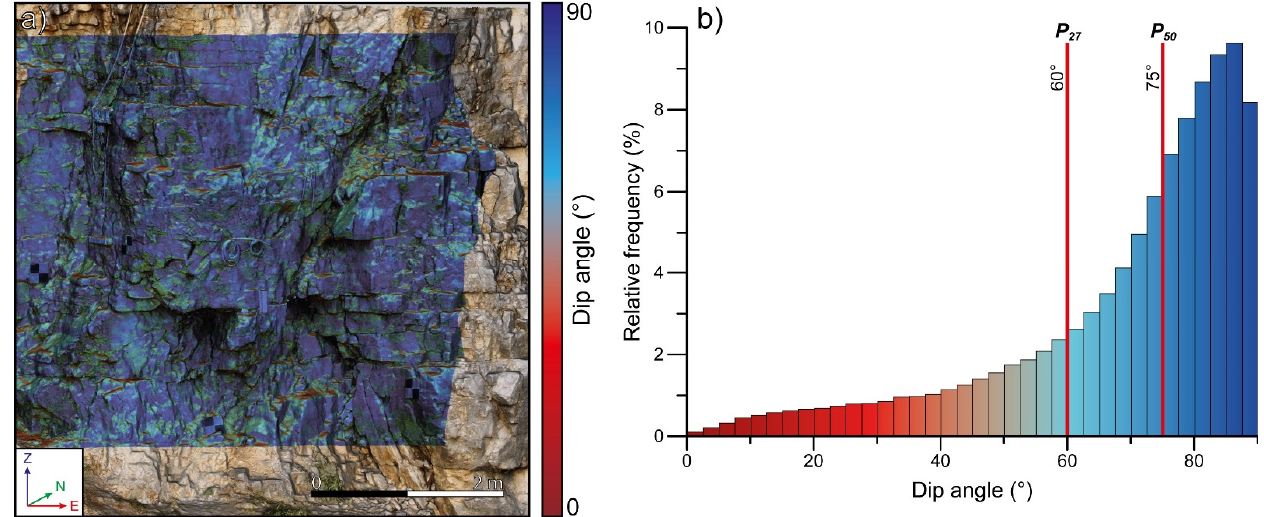
Figure 10. ( a ) Color-scale representation of the 3D point cloud dip angle values along with ( b ) the relative frequency distribution of dip angle classes. Dip angle values corresponding to the 27th and 50th percentile are marked in the histo- gram.